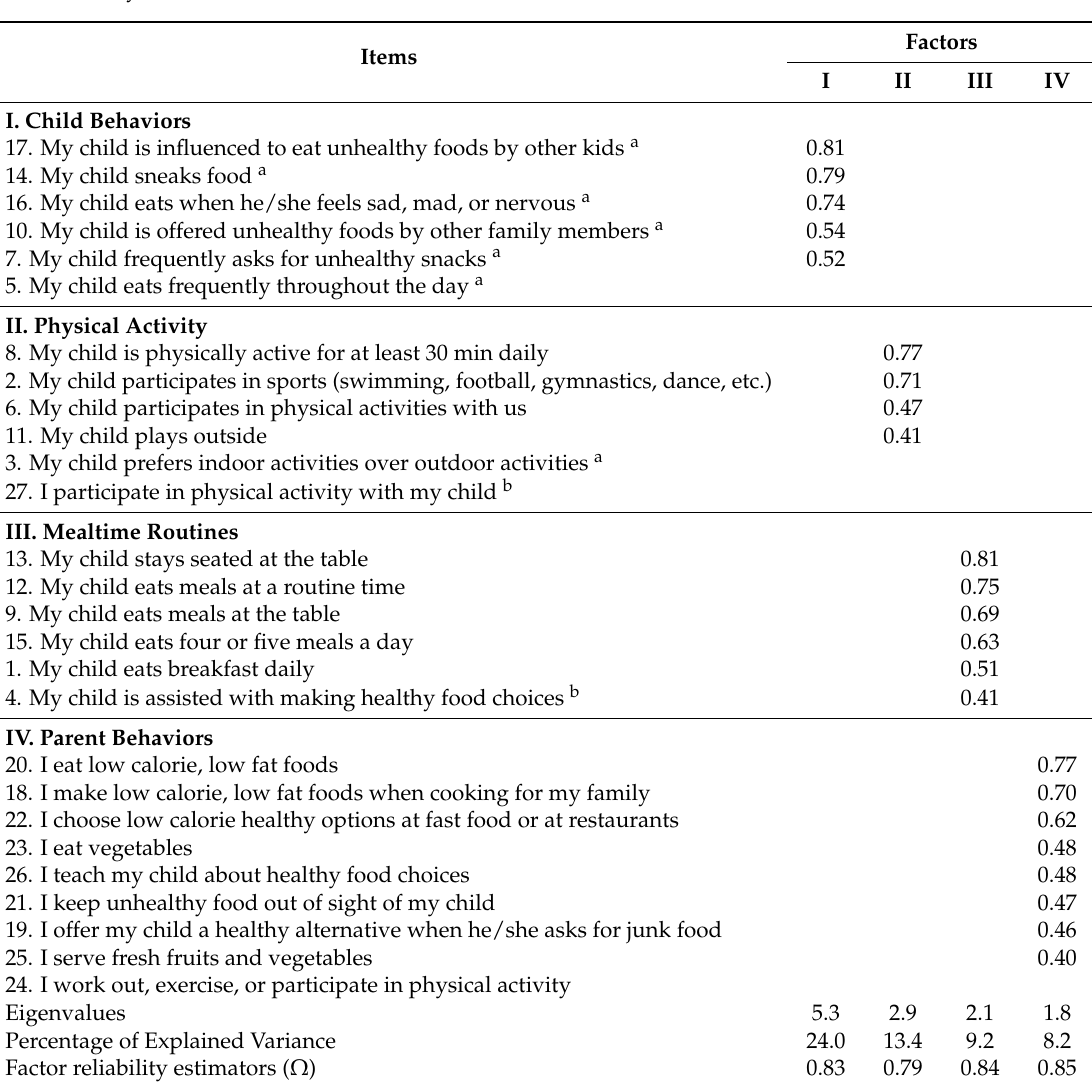
Matrix of rotated factorial loadings, factors’ eigenvalues, explained variances, and reliability